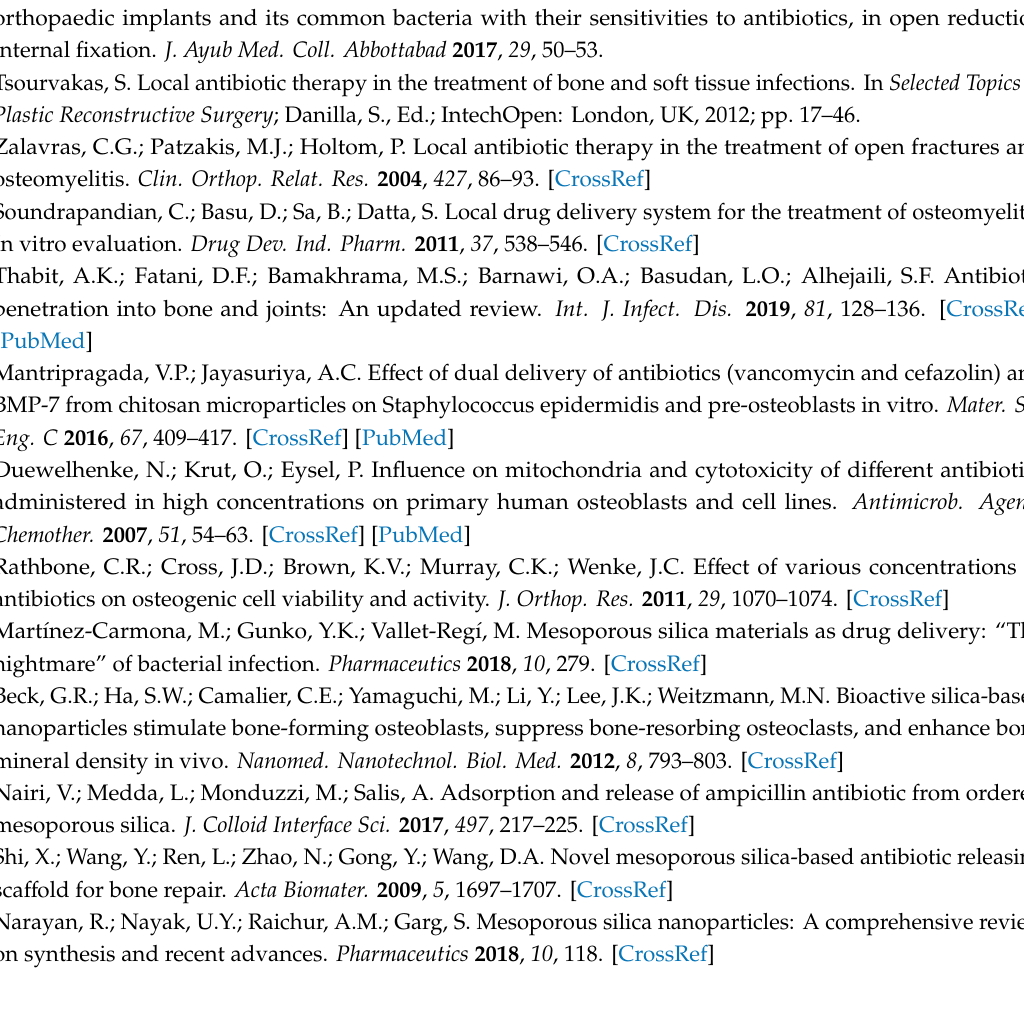
Table S1: Surface area, pore diameter and pore volume of MCM-41 and MCM-41-CIP powders, Figure S1: Particle size of MCM-41-CIP powder, Table S2: The kinetic parameters of fitted experimental data for MCM-41-CIP sample and EC / CIP, EC / PDMS / CIP, EC / MCM-41-CIP and EC / PDMS / MCM-41-CIP